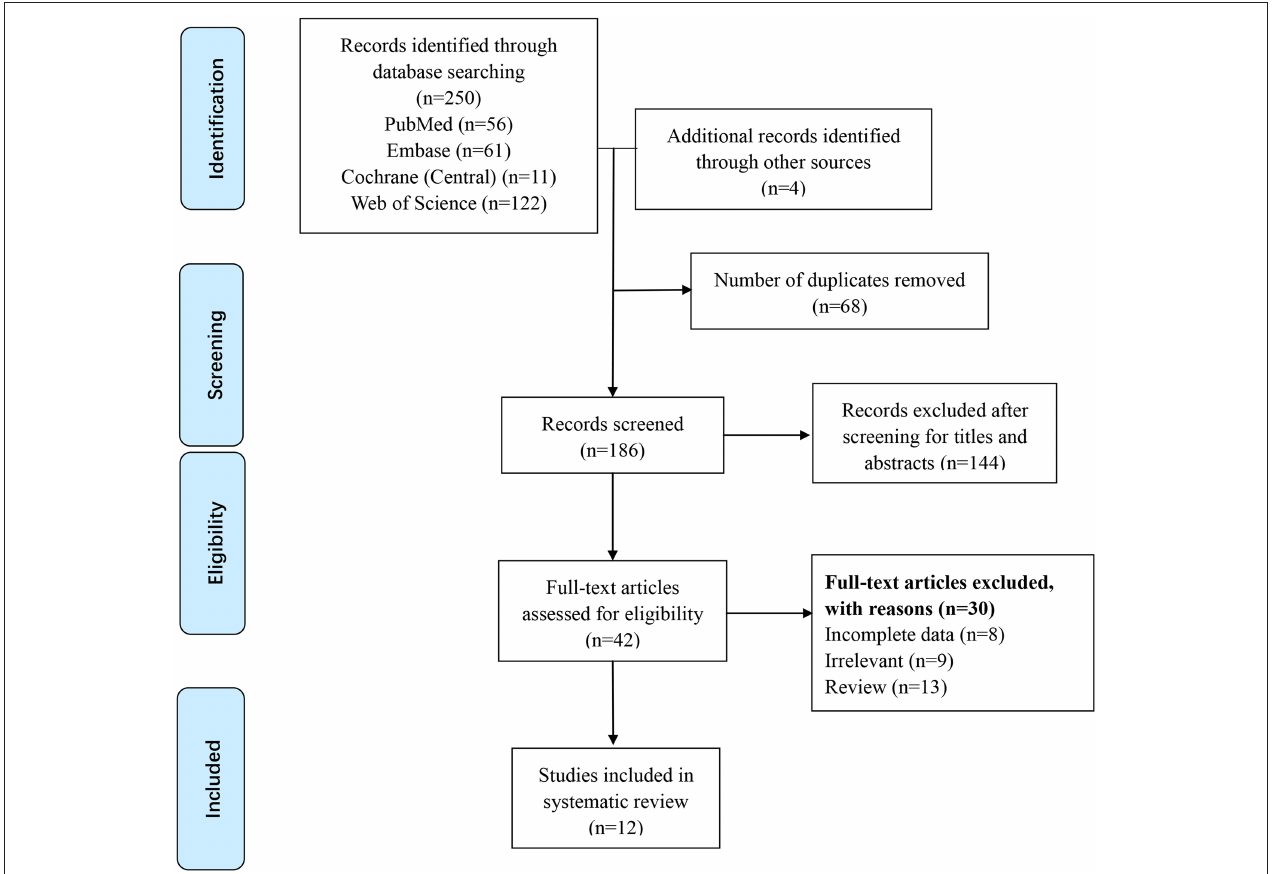
FIGURE 1 | Flow diagram of search results and study